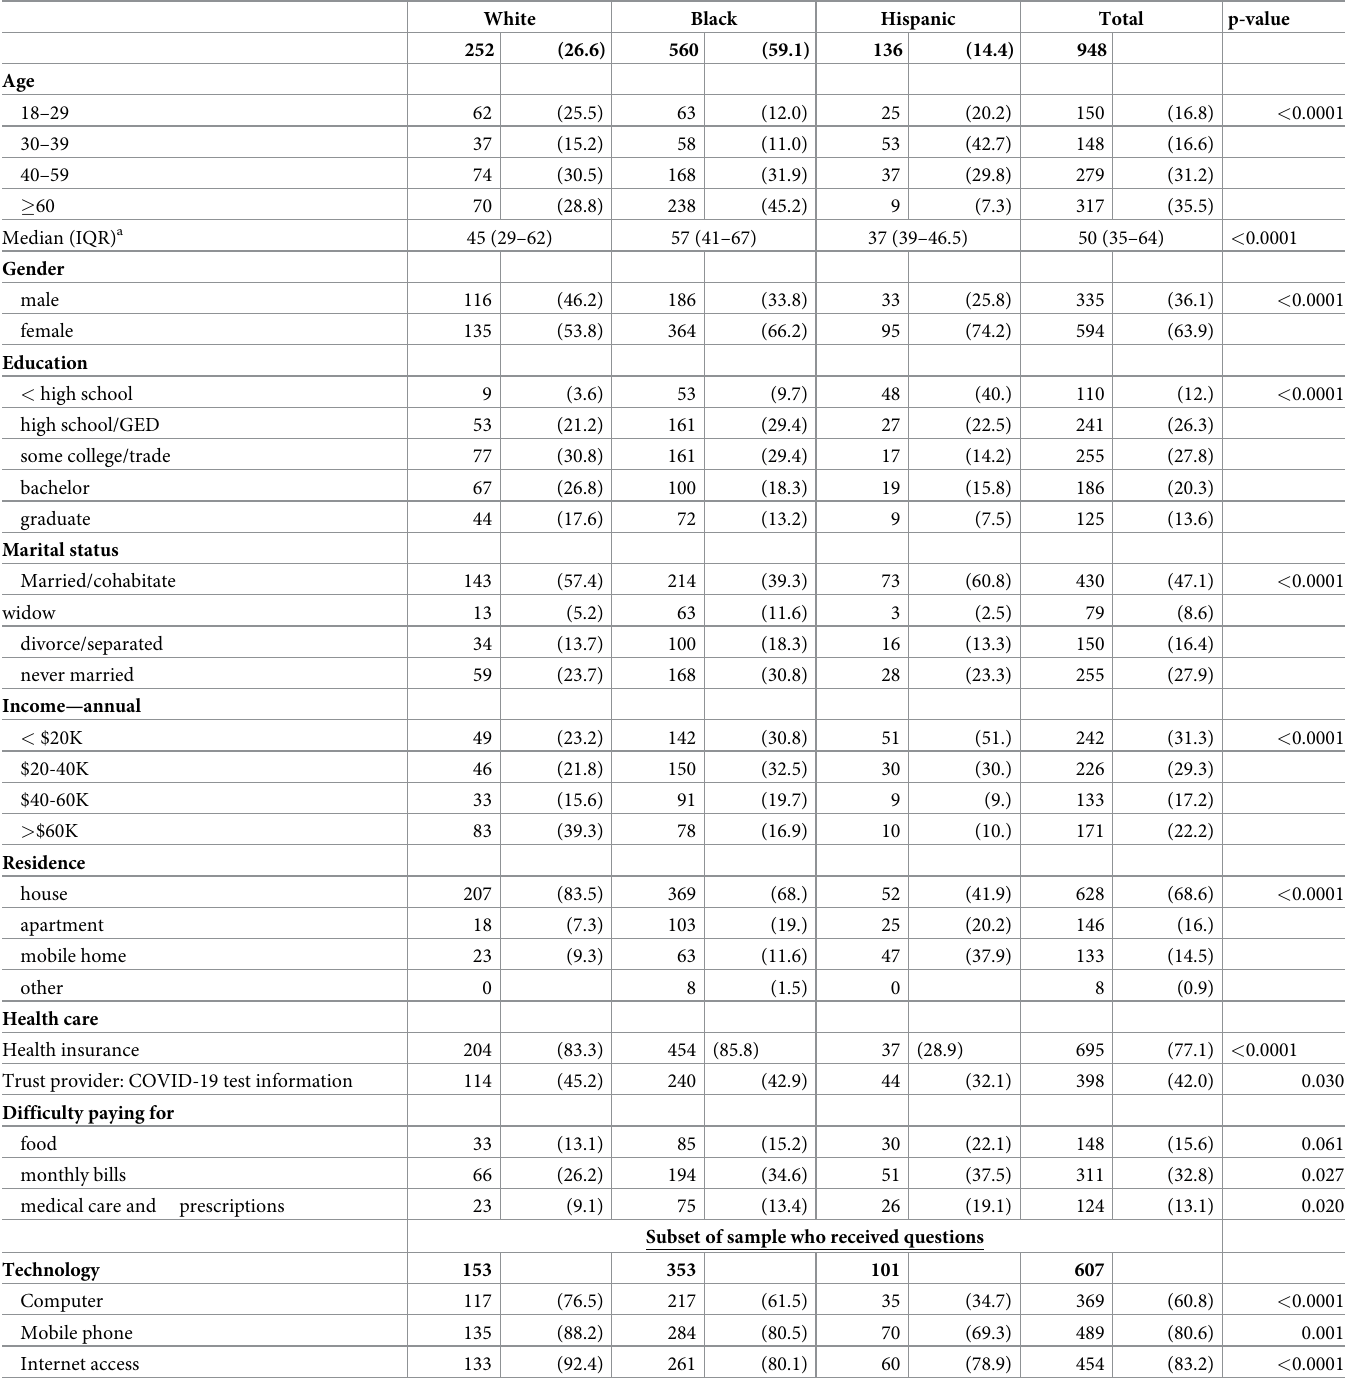
Table 1. Characteristics of ACCORD study respondents by race/ethnicity ACCORD study, August-December